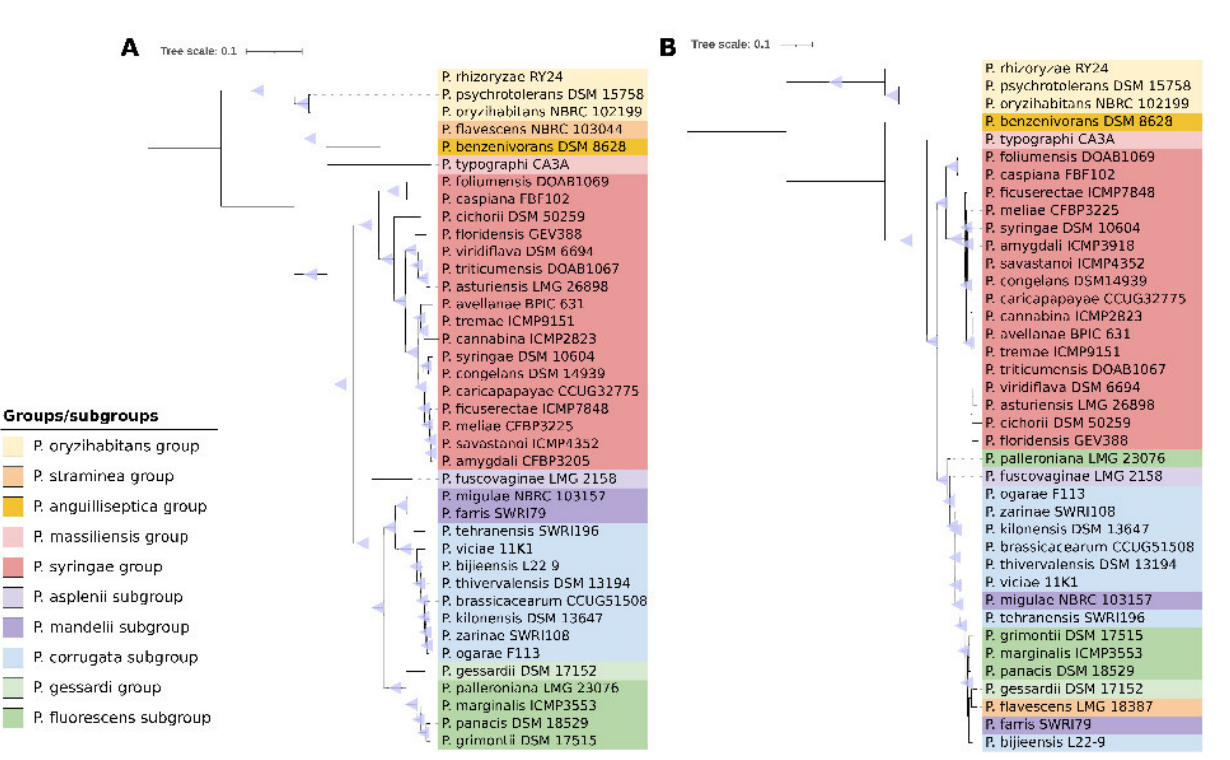
Figure 2. ( A ) Phylogram based on 576 core genes protein sequences from Pseudomonas type strains that possess acdS genes. The core genes (single copy genes found in all tested strains) were selected based on GHOSTKOALA functional annotation [66] and a python script built in house. The core genes were individually aligned using MAFFT [67] and concatenated using a python script built in house. The phylogenetic analysis was conducted in GalaxyPasteur server [68] using FastTree v2.1.10 [69], the LG model and a bootstrap of 100 replications. ( B ) Phylogram based on the AcdS sequences of Pseudomonas type strains. The sequences were obtained from the NCBI database and aligned using MAFFT [67]. The phylogenetic analysis was conducted in GalaxyPasteur server [68] using FastTree v2.1.10 [69], the LG model and a bootstrap of 1000 replications.